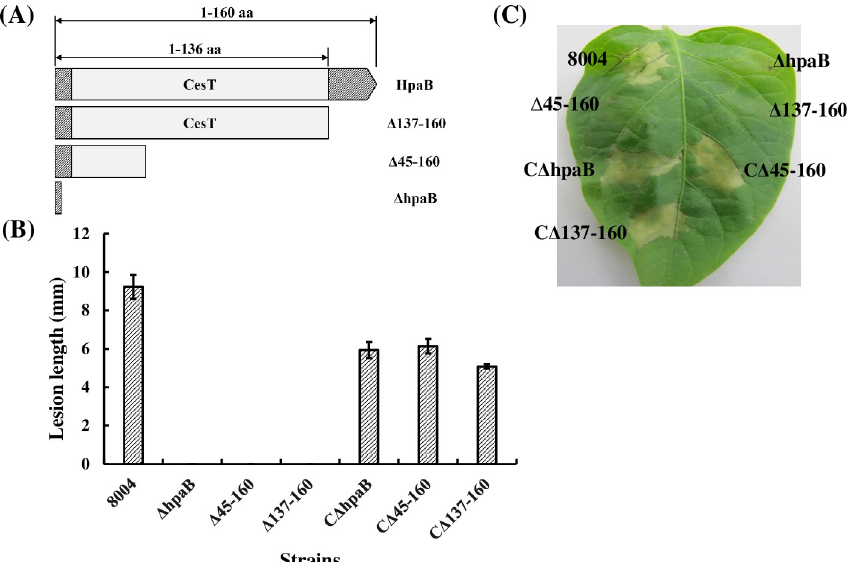
Fig 1. HpaB and its C-terminal domain are involved in virulence and HR induction in Xcc . ( A ) Schematic presentation of generation of hpaB deletion mutants. aa = amino acid residues. ( B ) The average lesion lengths of Chinese radish ( Raphanus sativus var. radiculus cv. Manshenhong) leaves caused by Xcc strains (wild type strain 8004, hpaB -deletion mutants, and hpaB -deletion mutants carrying hpaB -recombinant plasmid) with a cell density of OD 600 = 0.001 were measured 10 days post-inoculation. Values are the mean ± standard deviation from three repeats, each with at least 60 leaves. ( C ) Analysis of HR induced by Xcc strains. Bacteria of Xcc with a cell density of OD 600 = 0.1 were inoculated into the leaves of pepper plant ( Capsicum annuum cv. ECW-10R). Leaves were photographed at 24 h post-inoculation.